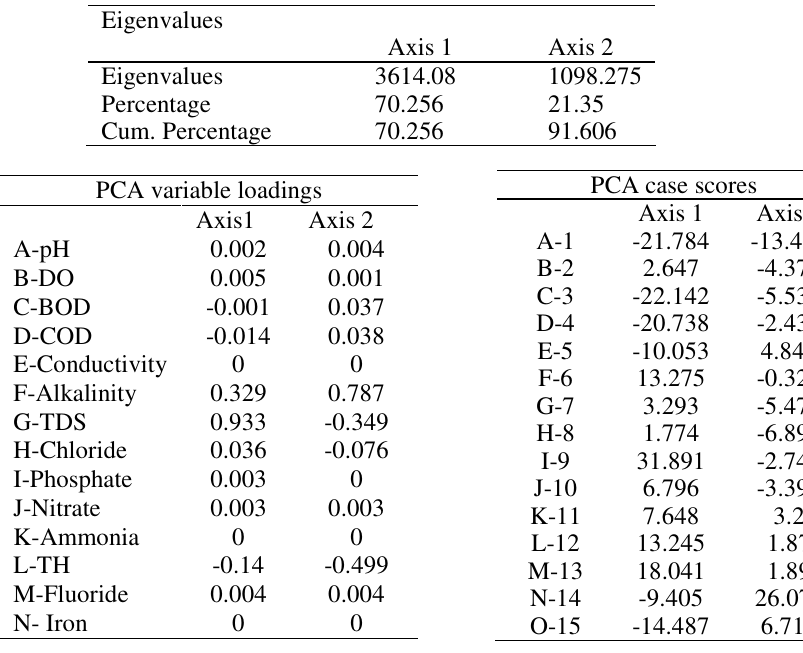
Table 7. Principal components